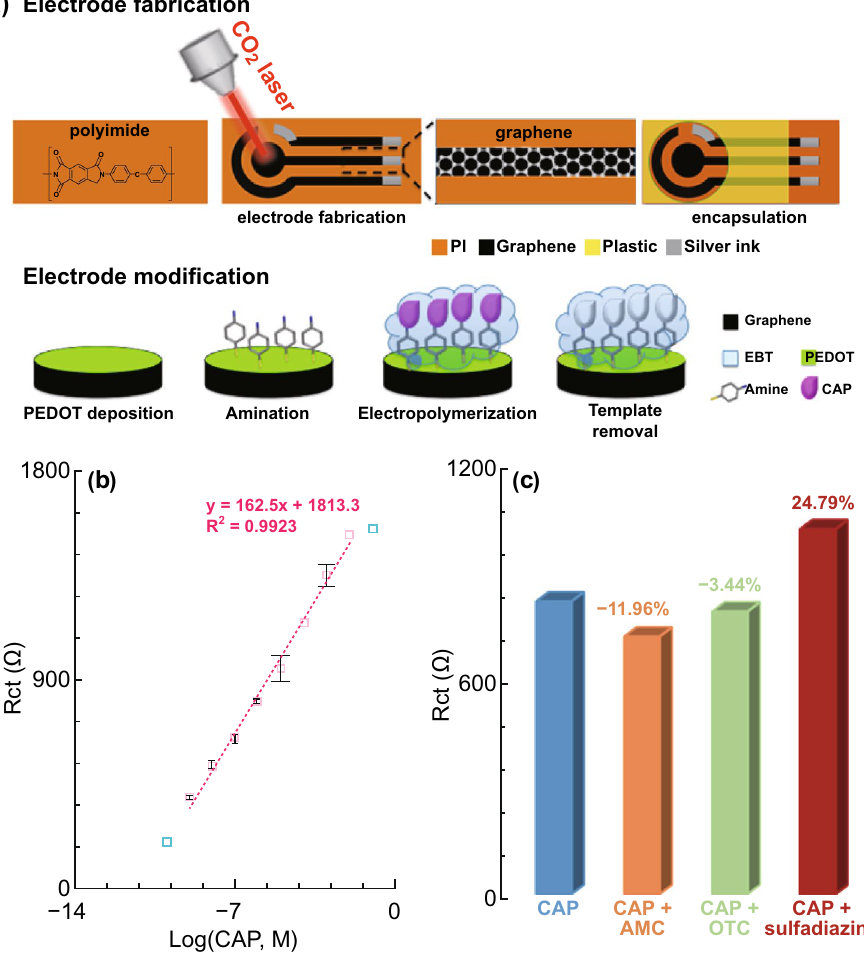
Fig. 3 Fabrication process and sensing performance of CAP sensor. a Schematic representation of the workflow employed on the production of the LIG electrodes (top) and the MIP fabrication (bottom) for the electrochemical biosensor for detection of CAP. b Dependence of R ct on CAP concentration. c Selectivity behavior of the biosensor for CAP against OTC, AMC and sulfadiazine. a – c Adapted with the permission from Ref. [48], Copyright 2018 Elsevier